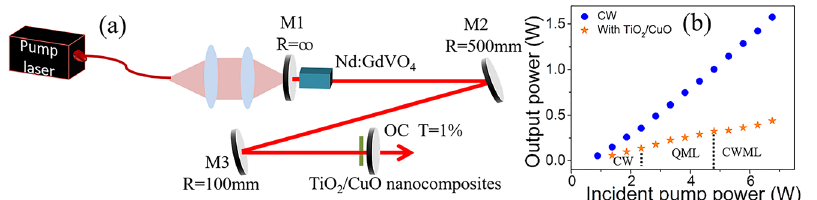
Figure 8: (a) Experimental setup of the continuous wave mode-locking (CWML) laser based on TiO 2 /CuO nanocomposites at 1.06 μ m. (b) Output power of CW and CWML regime versus the incident pump power.